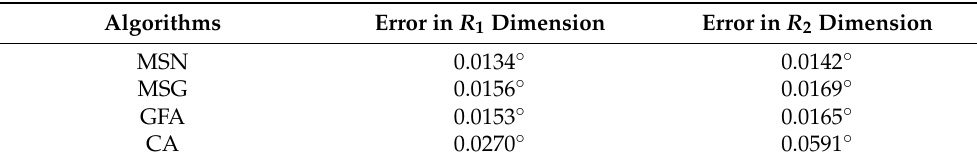
Table 1. Average prediction errors of different algorithms in the R 1 and R 2 dimensions based on the use of the novel partition prediction fitting